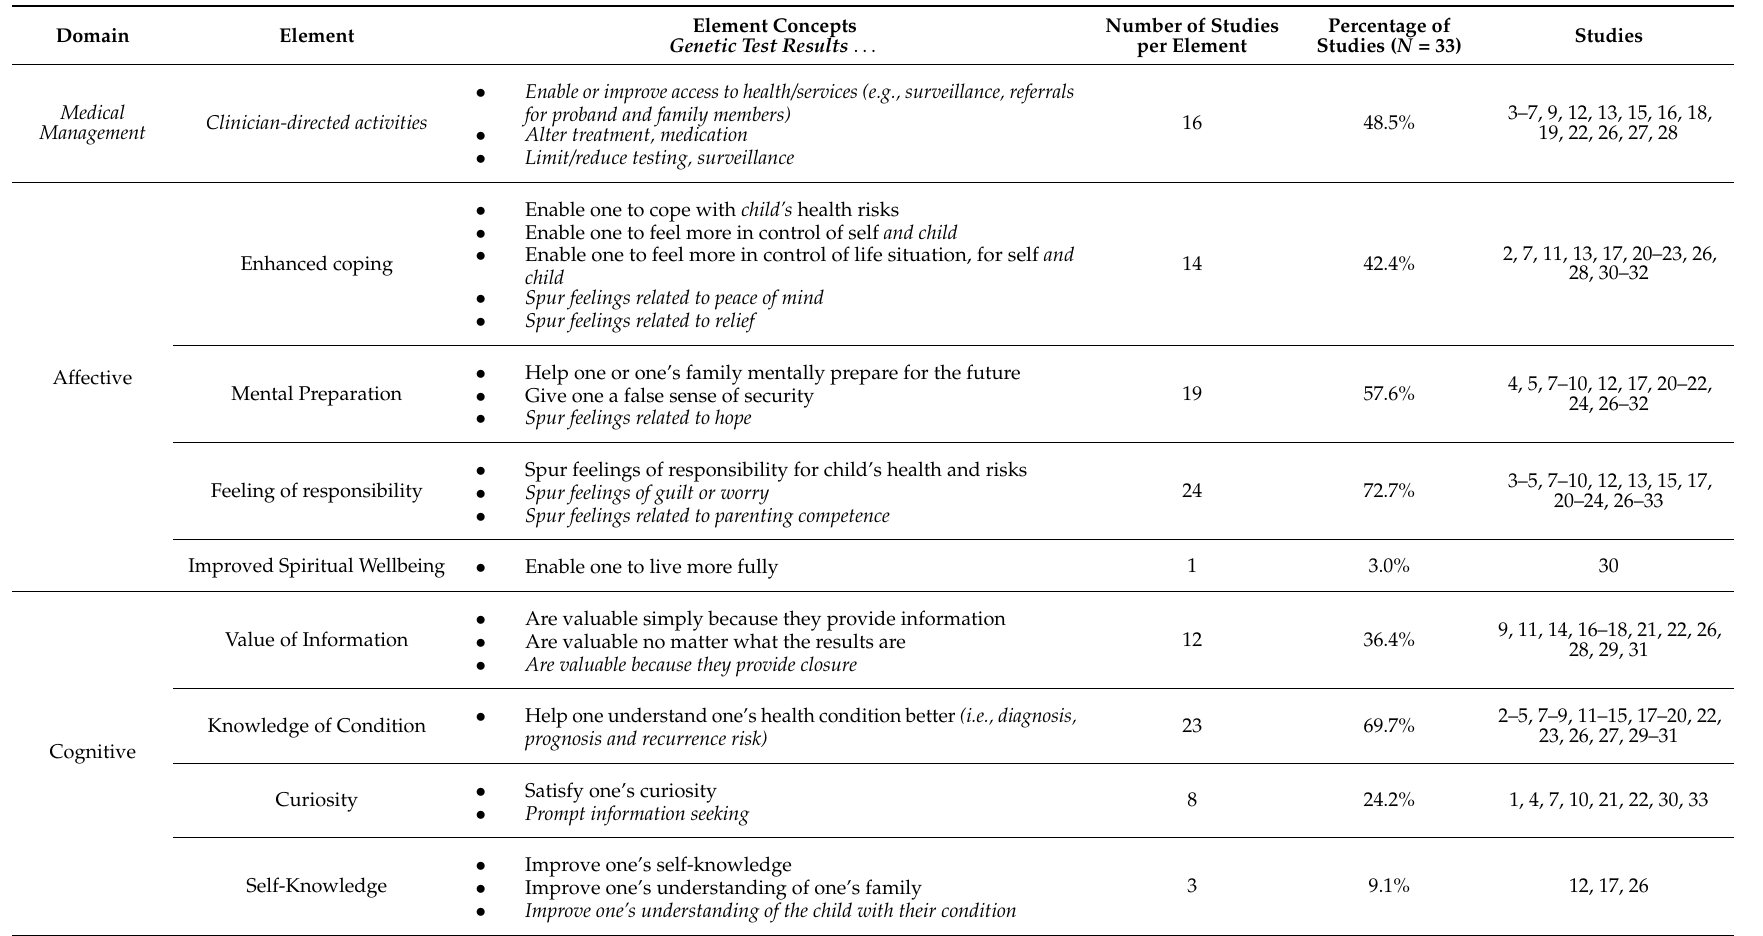
Table 2. Elements of personal utility from the perspective of